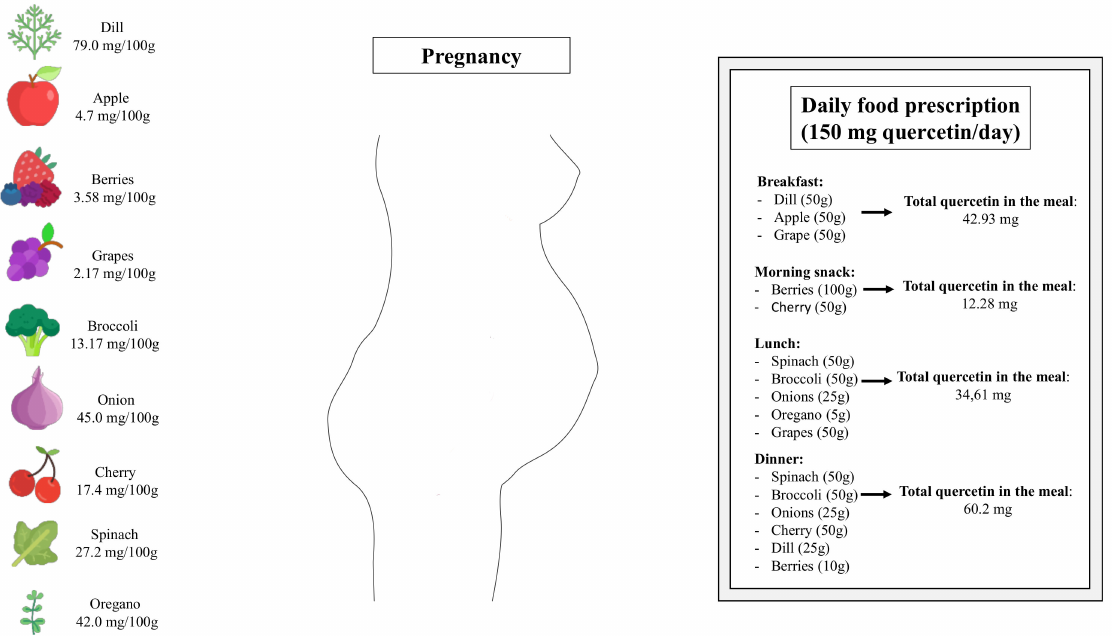
Figure 2. Schematic drawing showing sources of quercetin-rich fruits and vegetables and how the presence of certain foods can be essential in a planned food prescription during